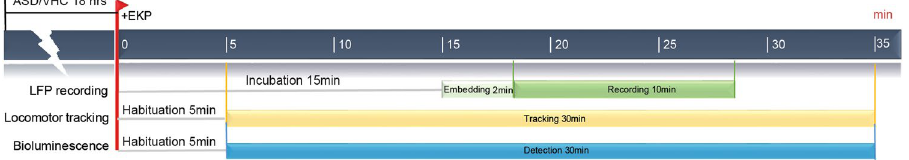
Figure 7. Schematic comparison of the experimental timelines as used for the locomotor tracking (yellow), LFP (green) and neuroluminescence recordings (blue). Key time points for each experimental protocol are